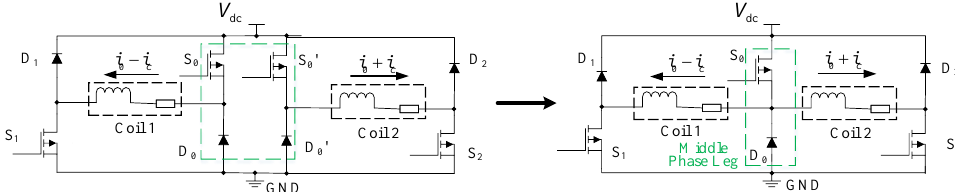
Figure 7. Three-phase-half-bridge topology of the SPA .